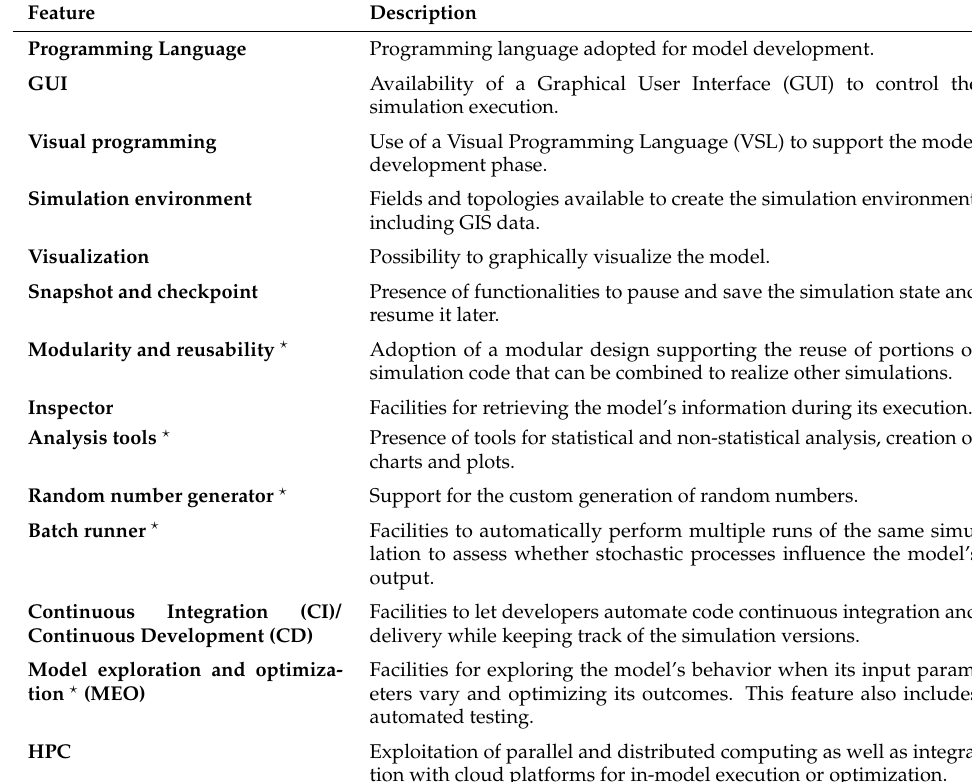
Table 2. Description of the desirable features for ABM